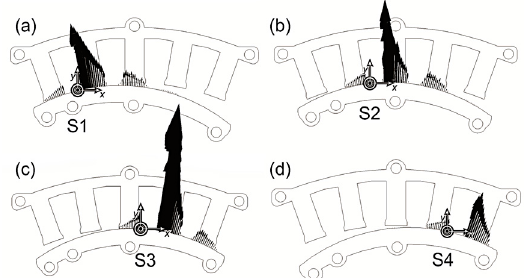
Figure 8. The numerically calculated and normalized surface force (N/m 2 ) distribution (XY cross section) at the characteristic coil switching points: ( a ) S1, ( b ) S2, ( c ) S3, and ( d ) S4.